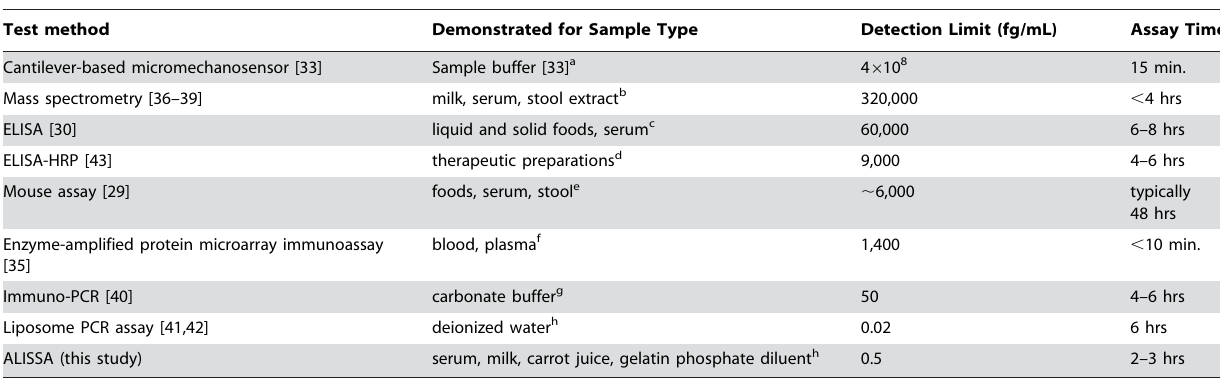
Table 1. Performance of existing botulinum toxin assays.